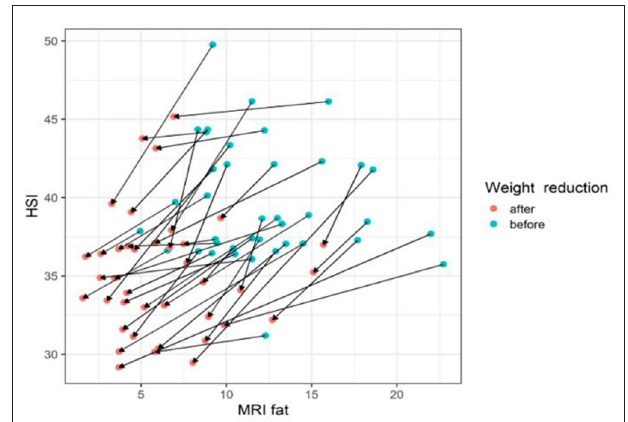
FIGURE 3 | The changes of HIS according to MRI fat before and after body weight reduction. The values of HSI and MRS tend to decrease with weight loss. The line slope representing the change is the ratio of the MRS decrease and the HSI decrease. Therefore, the HSI value changes appropriately according to the change amount of the MRI fat fraction. MRS, magnetic resonance spectroscopy; HSI, hepatic stenosis index. Blue circle, before weight reduction; red circle and arrows, after weight reduction.